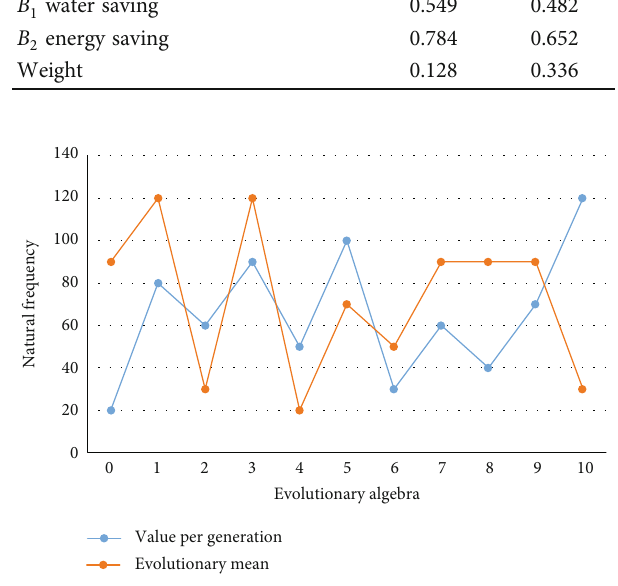
Figure 5: Evolution curve.